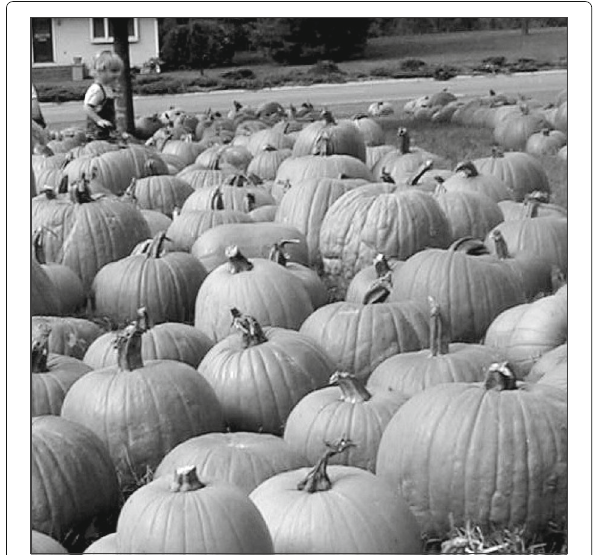
process of salt & pepper noise involves two steps. In the first stage, we replace the pixels with value 0 or 255 by the median of the neighboring pixels of radius 1 (8 pixels in noisy image P ). Next, we apply the regression model, Y SP = X SP · ω SP + (cid:5) , which is a linear regression model. Below is a detailed description of the response and the predictors: vector is Y SP [ r ] = P ( i , j ) . • For an element Y SP [ r ] = P ( i , j ) , the corresponding row X SP [ r , :] contains 1 (for intercept), and